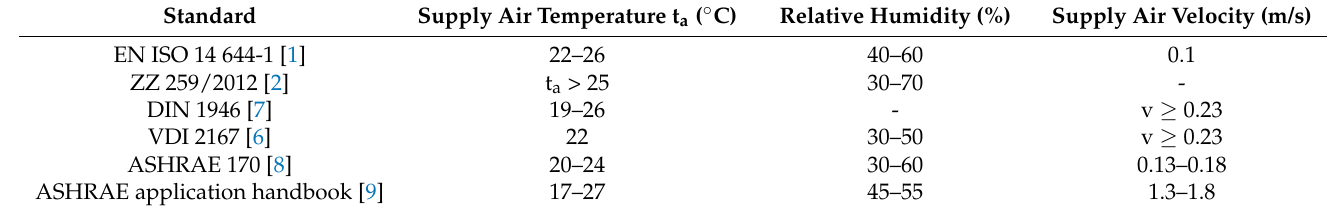
Table 1. Comparison of requirements for indoor microclimate in the OR as specified in different international standards.